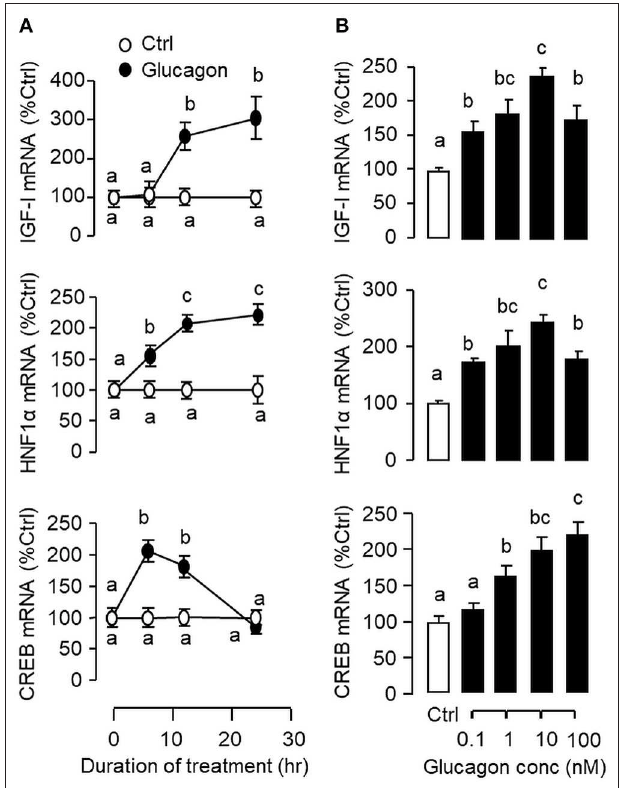
FIGURE 2 | Glucagon-induced IGF-I, HNF1 α , and CREB gene expression in primary culture of grass carp hepatocytes. (A) Time course and (B) Dose dependence of glucagon stimulation on IGF-I, HNF1 α , and CREB mRNA expression in carp hepatocytes. For the time course experiment, the dose of glucagon used was fixed at 10nM for the duration as indicated, while the duration of drug treatment was fixed at 12h for the dose-response study. After glucagon induction, total RNA was isolated from individual wells and used for real-time PCR using primers for carp IGF-I, HNF1 α , and CREB, respectively. Data presented are expressed as mean ± SEM and groups denoted by different letters represent a significant difference at p < 0.05 (ANOVA followed by Newman-Keuls test).